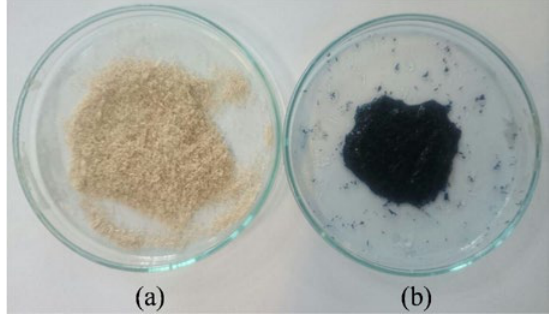
Fig. 2: Photographs of SD/MgO powder (a) and SD/MgO-loaded MB (b). Fig. 2. Photographs of SD/MgO powder (a) and SD/MgO-loaded MB (b).